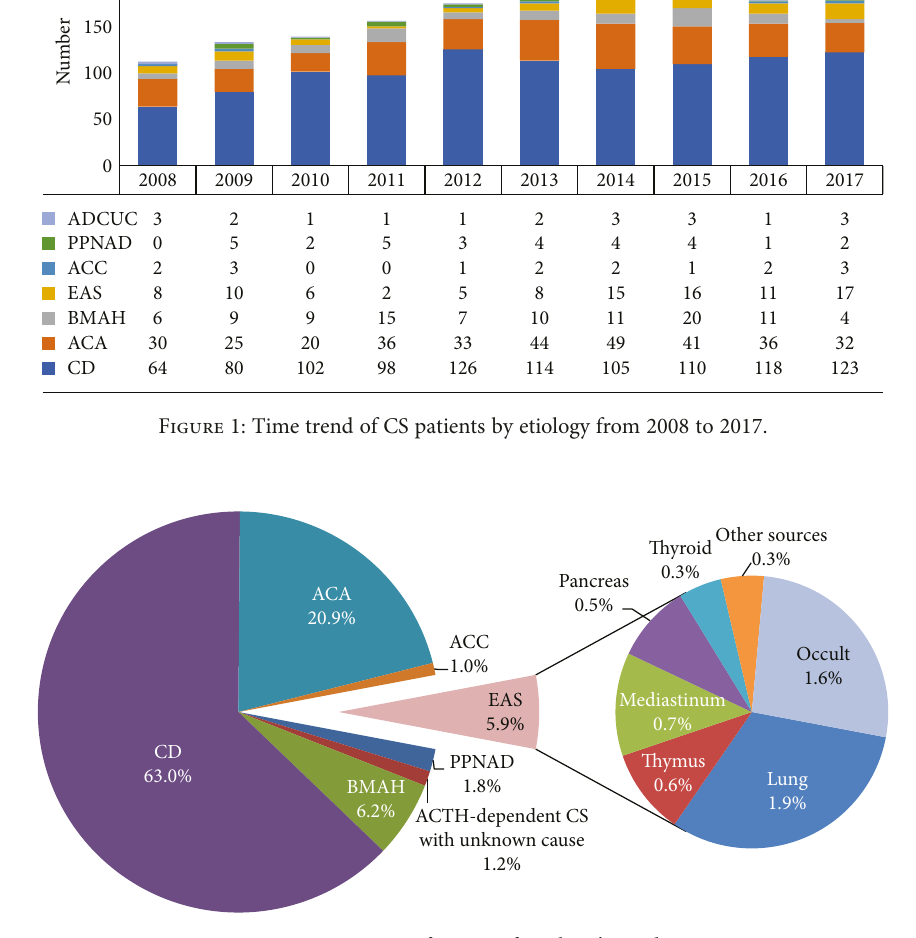
Figure 2: Proportion of causes of Cushing ’ s syndrome.